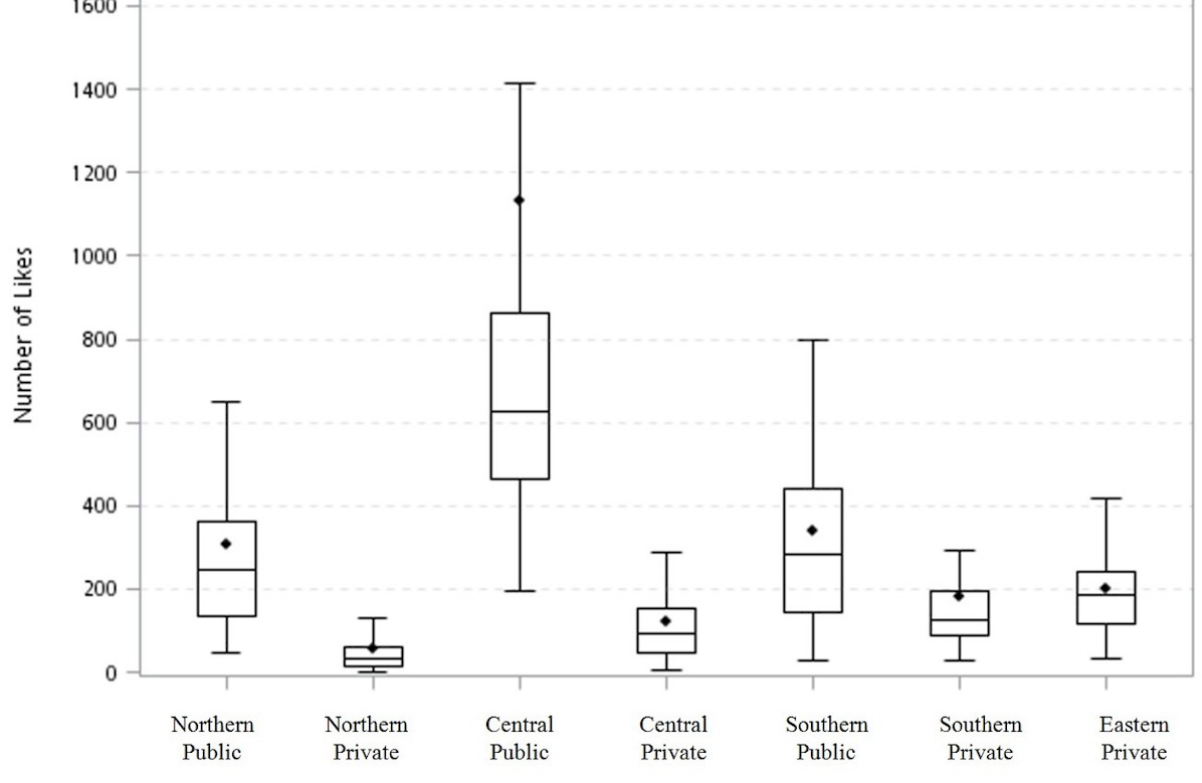
Figure 2. The number of "likes" on COVID-19 Facebook posts by nationwide medical centers in Taiwan, by region and